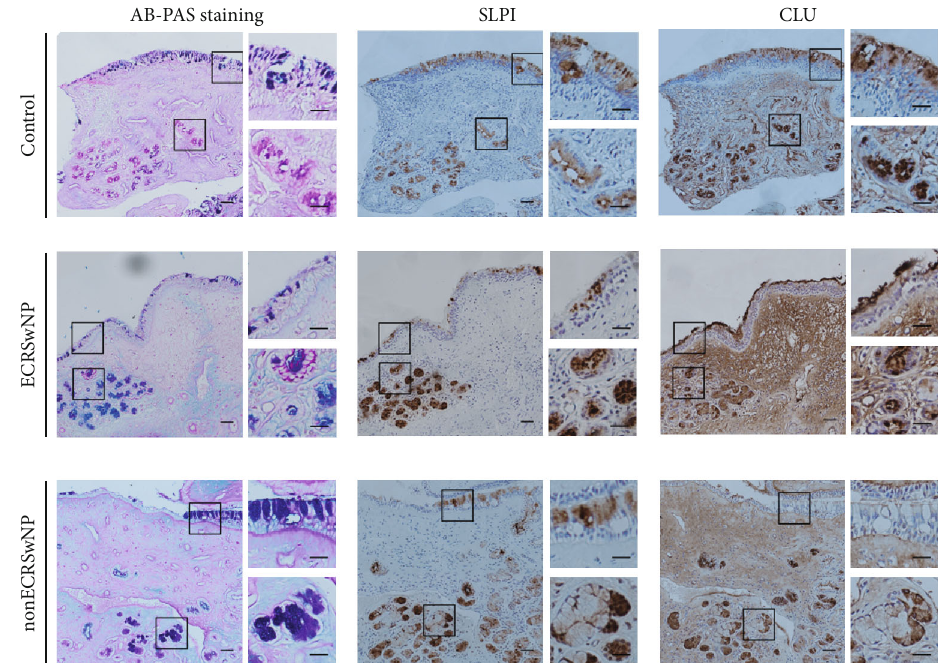
Figure 3: Evaluation of sequential staining for AB/PAS, SLPI, and CLU in nasal tissues. AB/PAS staining and immunohistochemical staining for SLPI and CLU were performed on serial sections of nasal tissues from ECRSwNP, nonECRSwNP, and healthy controls. Bars = 50 μ m. ECRSwNP: eosinophilic CRSwNP; nonECRSwNP: noneosinophilic CRSwNP; CLU: clusterin; SLPI: secretory leukoprotease